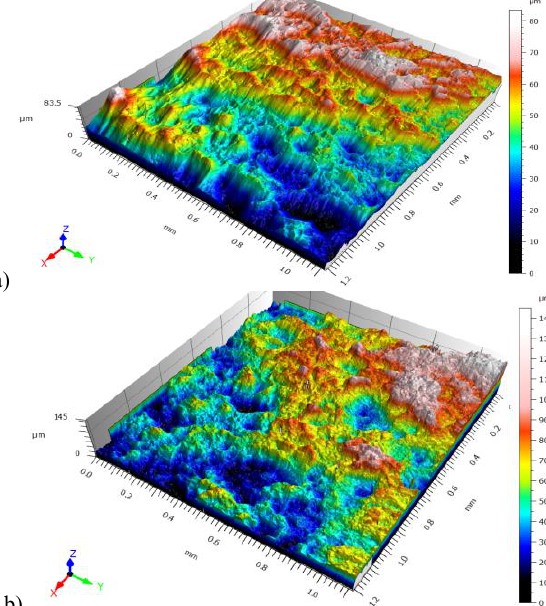
Fig. 6. Roughness surface steel S355J2 specimen subjected to combined bending-torsion loading, with magnitude 100x, for a) the propagation area, b) the rupture area.